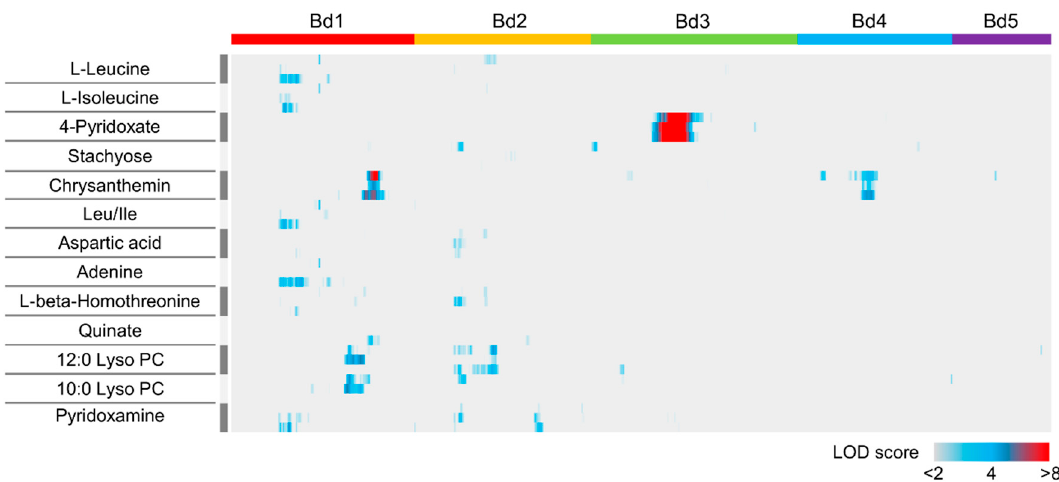
Figure 3. Results of mQTL analysis using an RIL population from the cross Bd3-1 × Bd21. Heat map representing the distribution of LOD scores for 17 metabolites across five chromosomes (Bd1, Bd2, Bd3, Bd4 and Bd5) in B. distachyon . The heat map for each metabolite is created using three replicates.